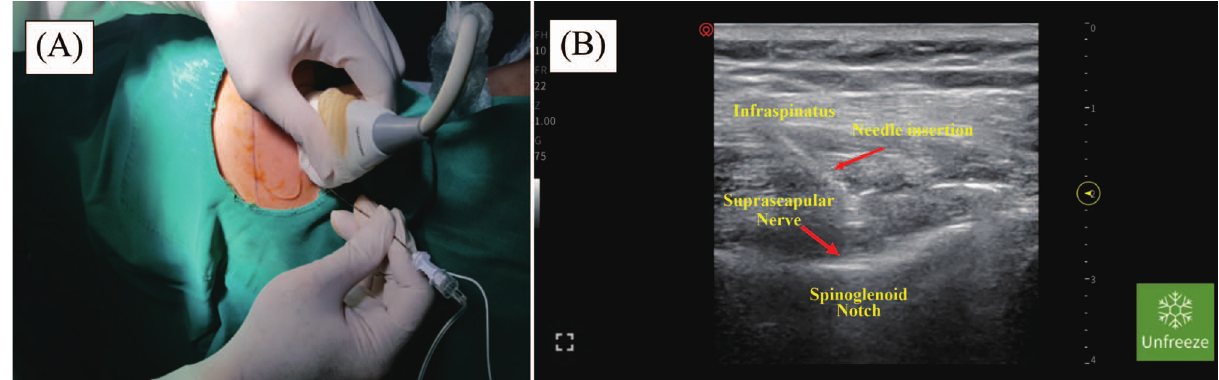
Figure 1. The suprascapular nerve at the supraglenoid notch using USG. The operator stands behind the patient, parallel to the ultrasound monitor, to achieve an ergonomic position. The ultrasound monitor is placed in front of the patient. The patient is in a lateral decubitus position, with the affected palm against the nonaffected shoulder and padding to protect the prominent area of the body. A sterile technique was used to prepare and clean the affected shoulder. The injection site for the suprascapular nerve block at the spinoglenoid notch is 2 cm below the spine scapula (A). An echogenic 23-G (3.5 in) spinal needle is inserted from medial to lateral (B). Injection (20 mg triamcinolone acetonide, 4 mL 2% lidocaine, and 4 mL 0.5% bupivacaine as a cocktail) was given and waited for 1 – 2